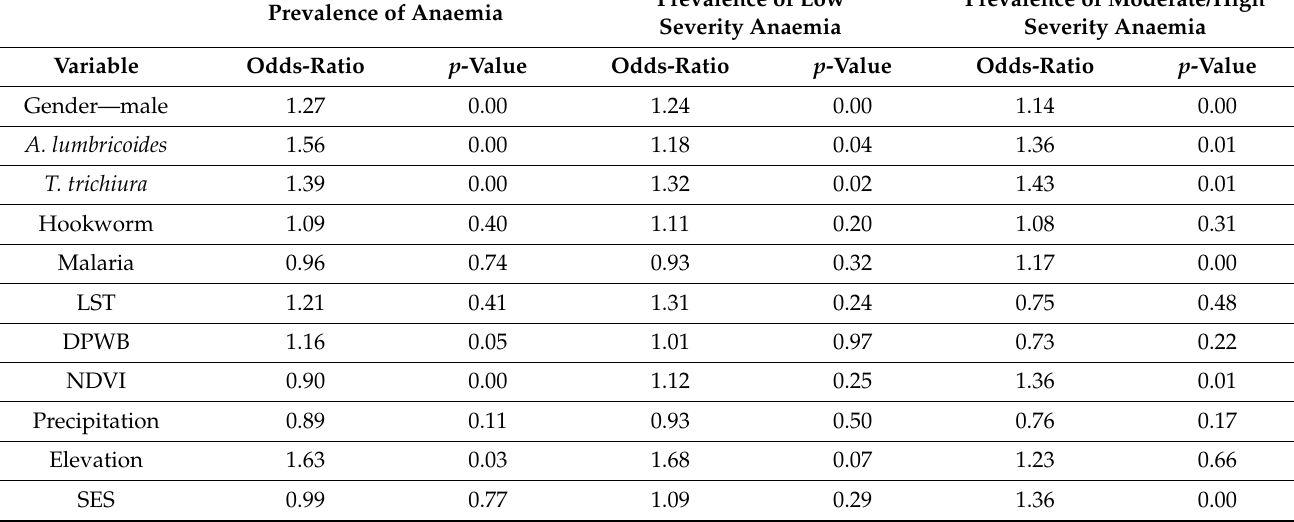
Table 3. Results of the final non-spatial statistical models for factors associated with the prevalence of anaemia and of anaemia severity in Burundi,